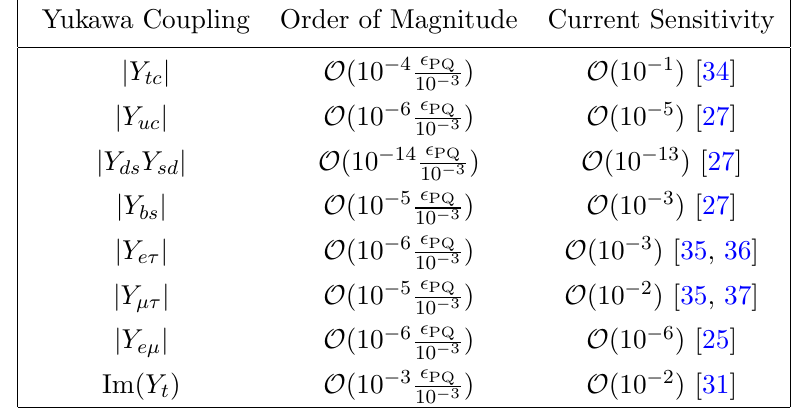
Table 2. The order of non-NFC Yukawa couplings in the FN-2HDM, and the current experimental sensitivity to these